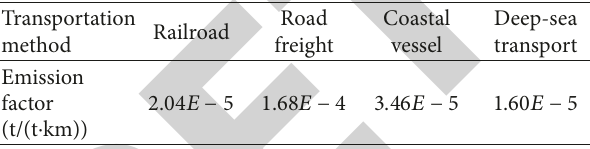
Table 3: CO emission factors for different transportation methods. 2